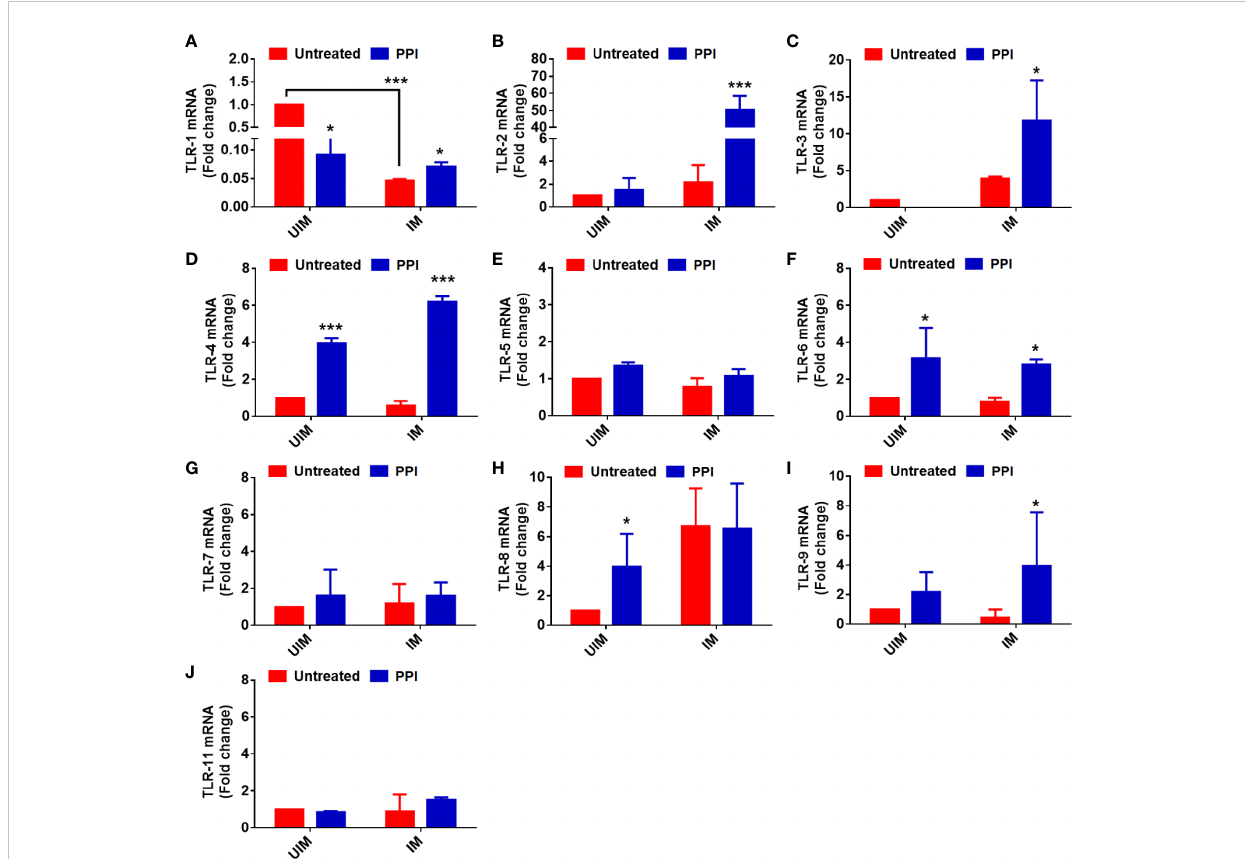
FIGURE 1 Effect of the protein protease inhibitor (PPI) on the mRNA expression of Toll-like receptors (TLRs) in uninfected macrophages (UIM) and infected macrophages (I.M.). (A – J) Macrophages were cultured and were infected with stationary-phase L. donovani promastigotes in a 1:10 (macrophage/ parasite) ratio. After 4 h, non-ingested parasites were removed by washing with sterile phosphate-buffered saline. After 24 h of infection, the macrophages were treated with or without PPI. After 4 h of PPI treatment, the cells were collected in Trizol. The mRNA expression of TLR-1 to TLR- 11 was determined in triplicate using real-time PCR. All the experiments were repeated at least two times, and data from one representative experiment were shown here as mean ± SD of relative fold change compared with uninfected control. The asterisks indicate a signi fi cant difference upon comparing the respective untreated PPI and the treated PPI groups. * p ≤ 0.05 and *** p ≤